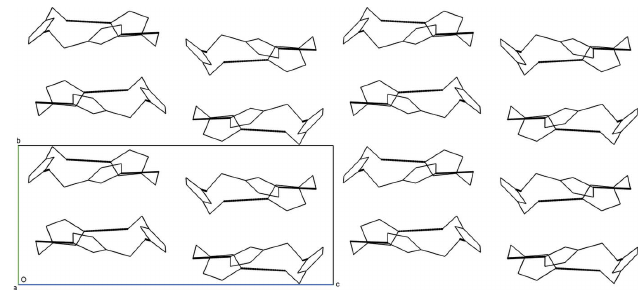
Figure 3 The packing arrangement of the three-molecule supermolecule with hydrogen bonds represented as dashed lines as viewed along the c axis of the unit cell. Observed at this angle is the (cid:2) -stacking of molecule 1 with itself across an inversion center.